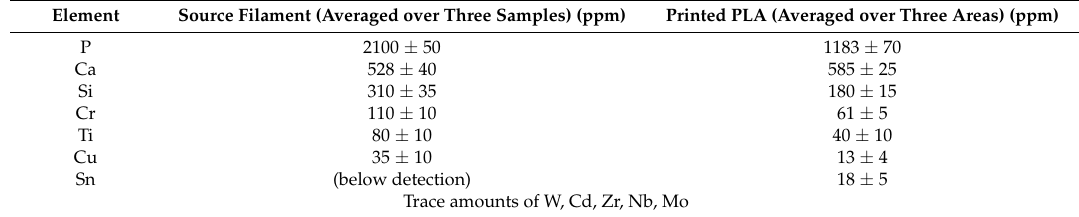
Table 1. Results of XRF measurements from PLA natural source filament and printed PLA. Element Source Filament (Averaged over Three Samples)